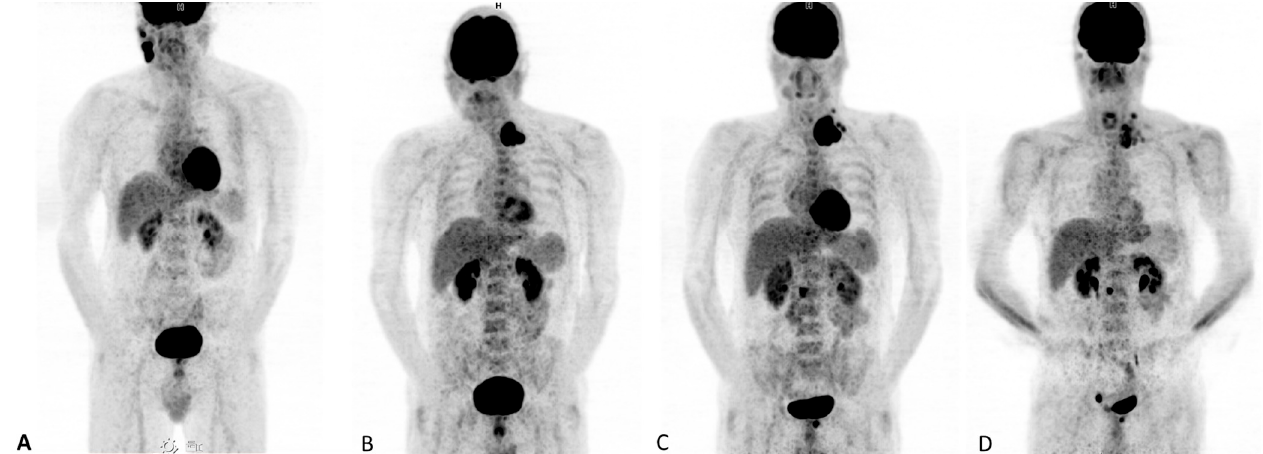
Figure 3. 48-year-old man with right temporal melanoma operated in 2016. ( A ) Tumoral progression in laterocervical lymphadenopathies and intraparotid adenopathy in the right side. ( B ) [ 18 F]FDG PET/CT 3 months later, under treatment with Dabrafenib and Trimetinib, shows a complete response in the right side with lymphadenopathic progression on the left side, where a new conglomerate is identified. ( C ) Control after one month shows lymphadenopathic progression and two new lesions in lumbar spine and pubis. ( D ) After 4 cycles of Nivolumab and Ipilimumab, there is improvement in cervical lymph node involvement, while bone progression is observed in pelvis. This evolution suggests dissociated response.